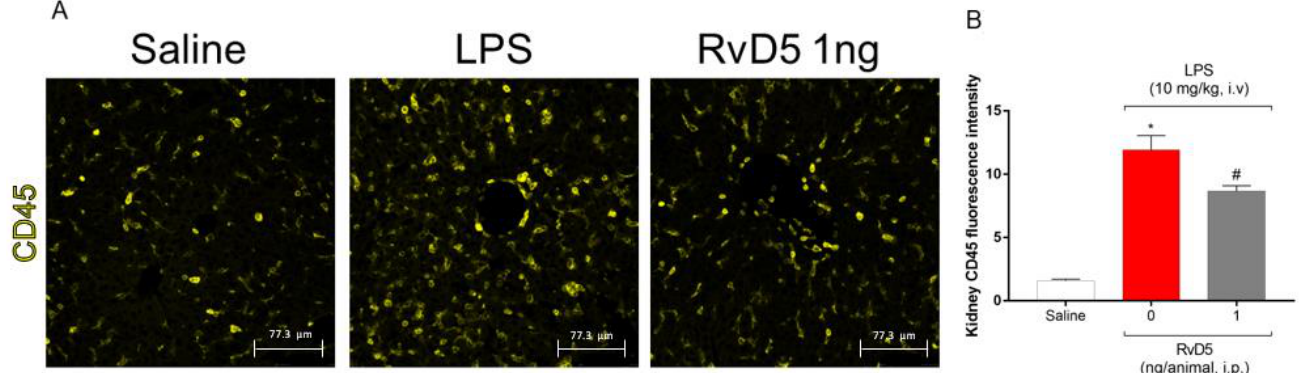
Figure 7. RvD5 reduces the infiltration of CD45+ hematopoietic leukocytes staining in the kidneys. Representative images ( A ) and CD45 + fluorescence intensity ( B ). Results are presented as standard ± SEM (standard error mean) one-way ANOVA followed by Tukey’s post-test) of six animals per group and are representative of two replicates. Scale bar: 77.3 µm. (* p < 0.05 vs. saline, # p < 0.05 vs. LPS 10 mg/kg).